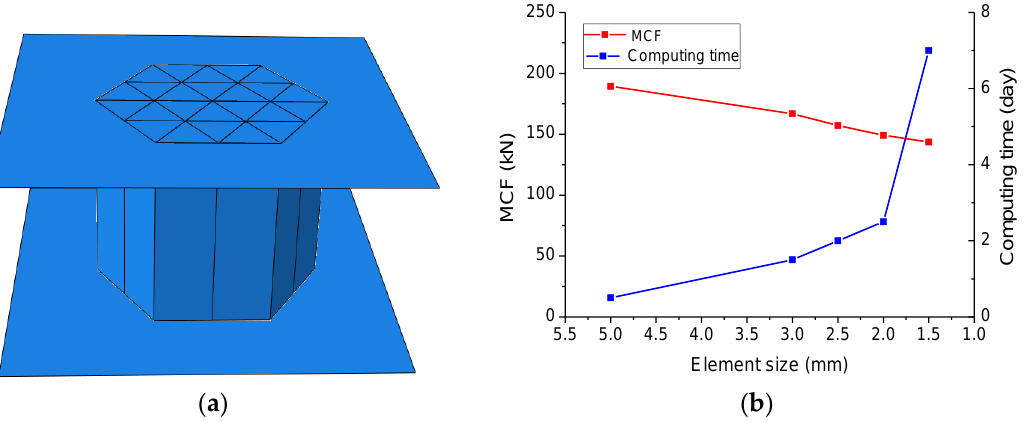
Figure 11. ( a ) Finite element model of tube HMT-2 and ( b ) effect of element size on simulated MCF